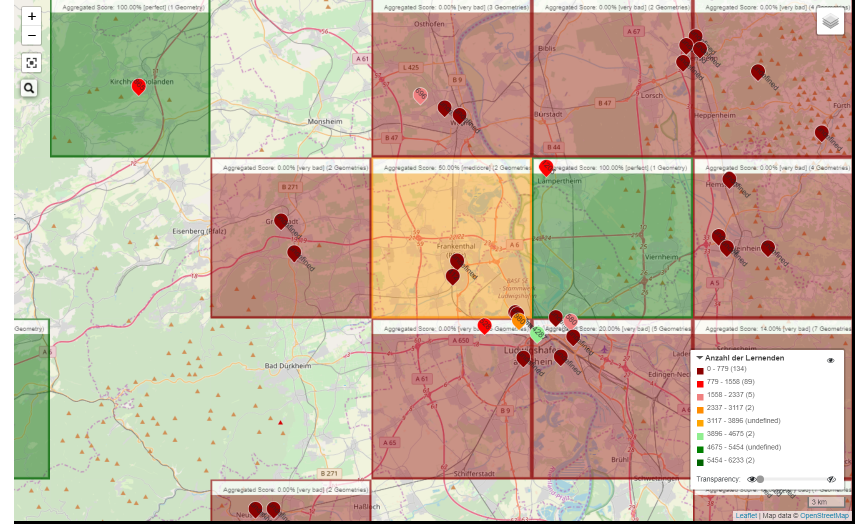
Figure 9. Thematic Map School_Rescue exposing the quality of a map highlighting the number of students from green = good to red = bad. Rescue operators may use this information to estimate rescue efforts in the case of a disaster. Areas with low school coverage should prompt the authorities not to plan the rescue using this map